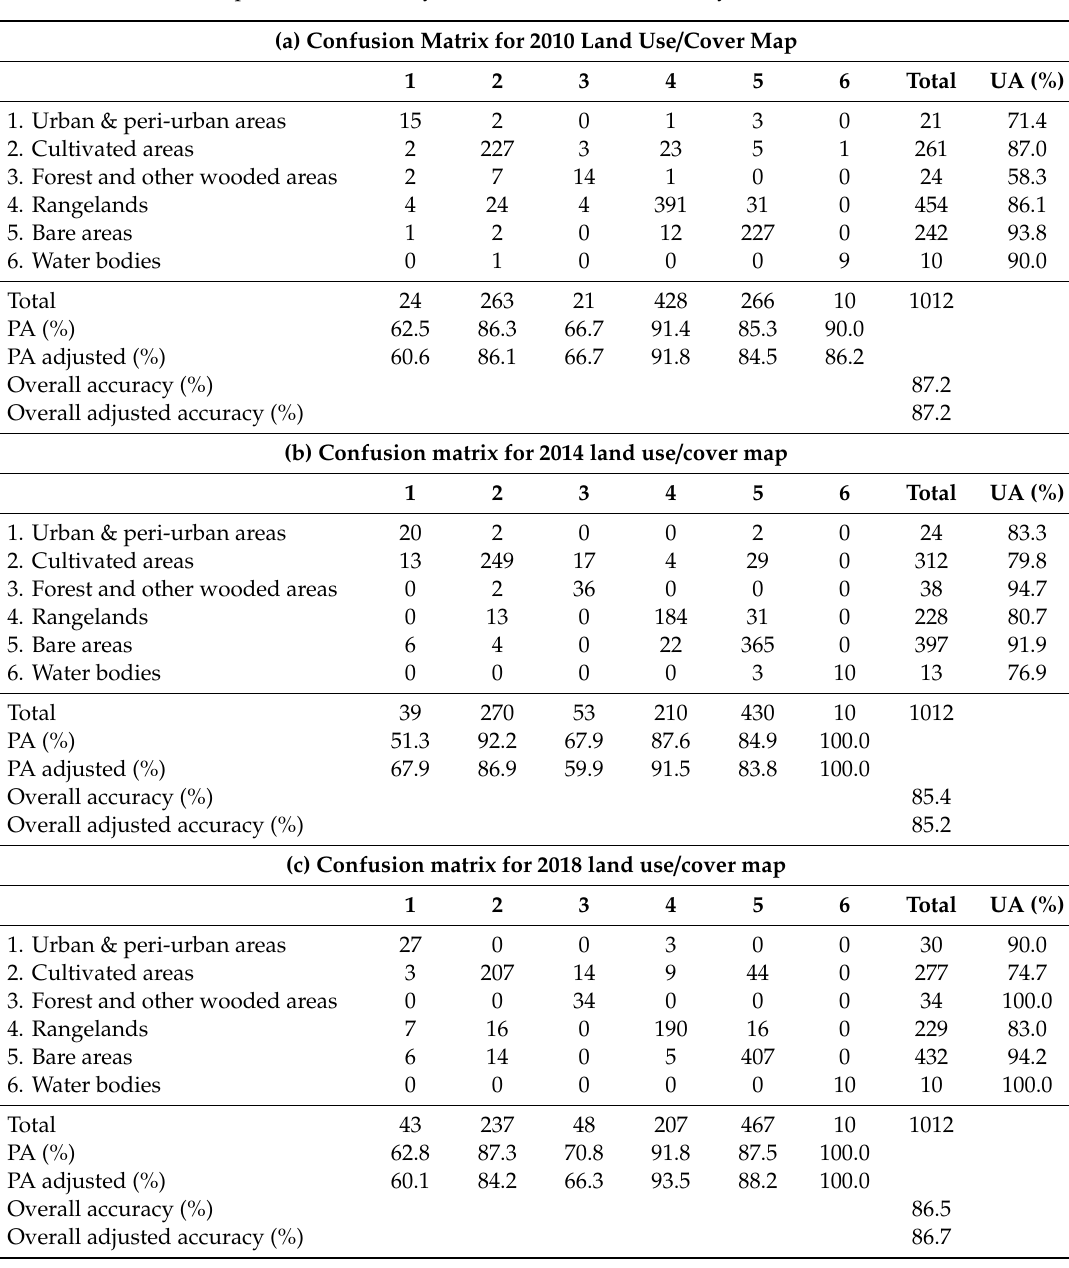
Table 4. Confusion matrices containing the (adjusted and not-adjusted) accuracy assessment of the classified LULC categories in Syria using a (slightly modified) stratified sample for the years 2010, 2014, and 2018. Here, the producer´s accuracy is PA and the user´s accuracy is